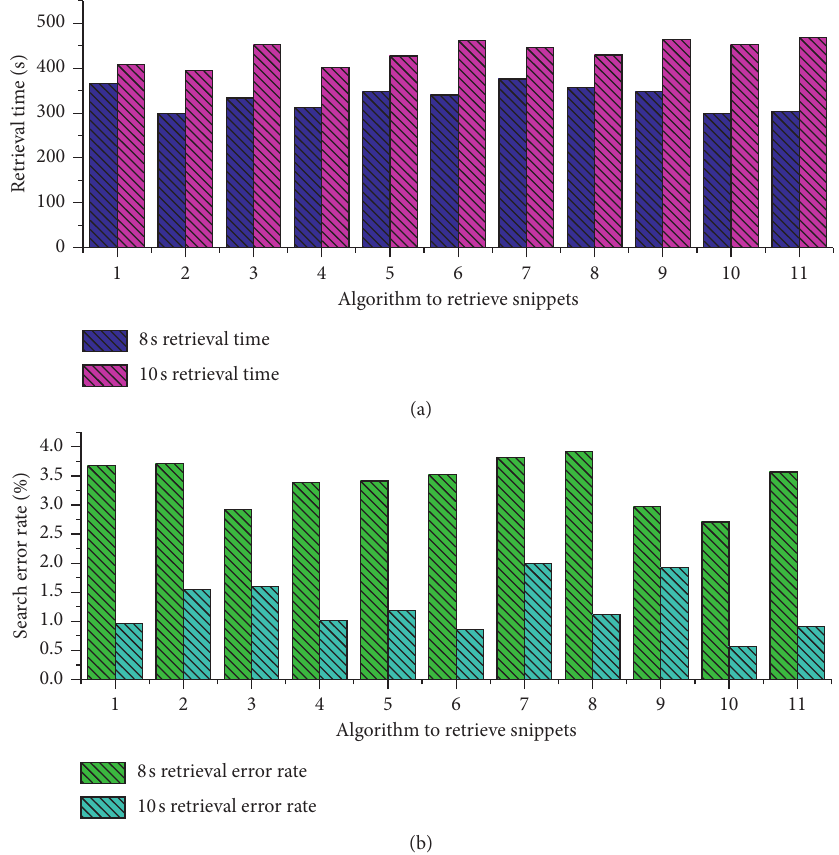
Figure 3: Effect of different comparison algorithms on retrieval time and error